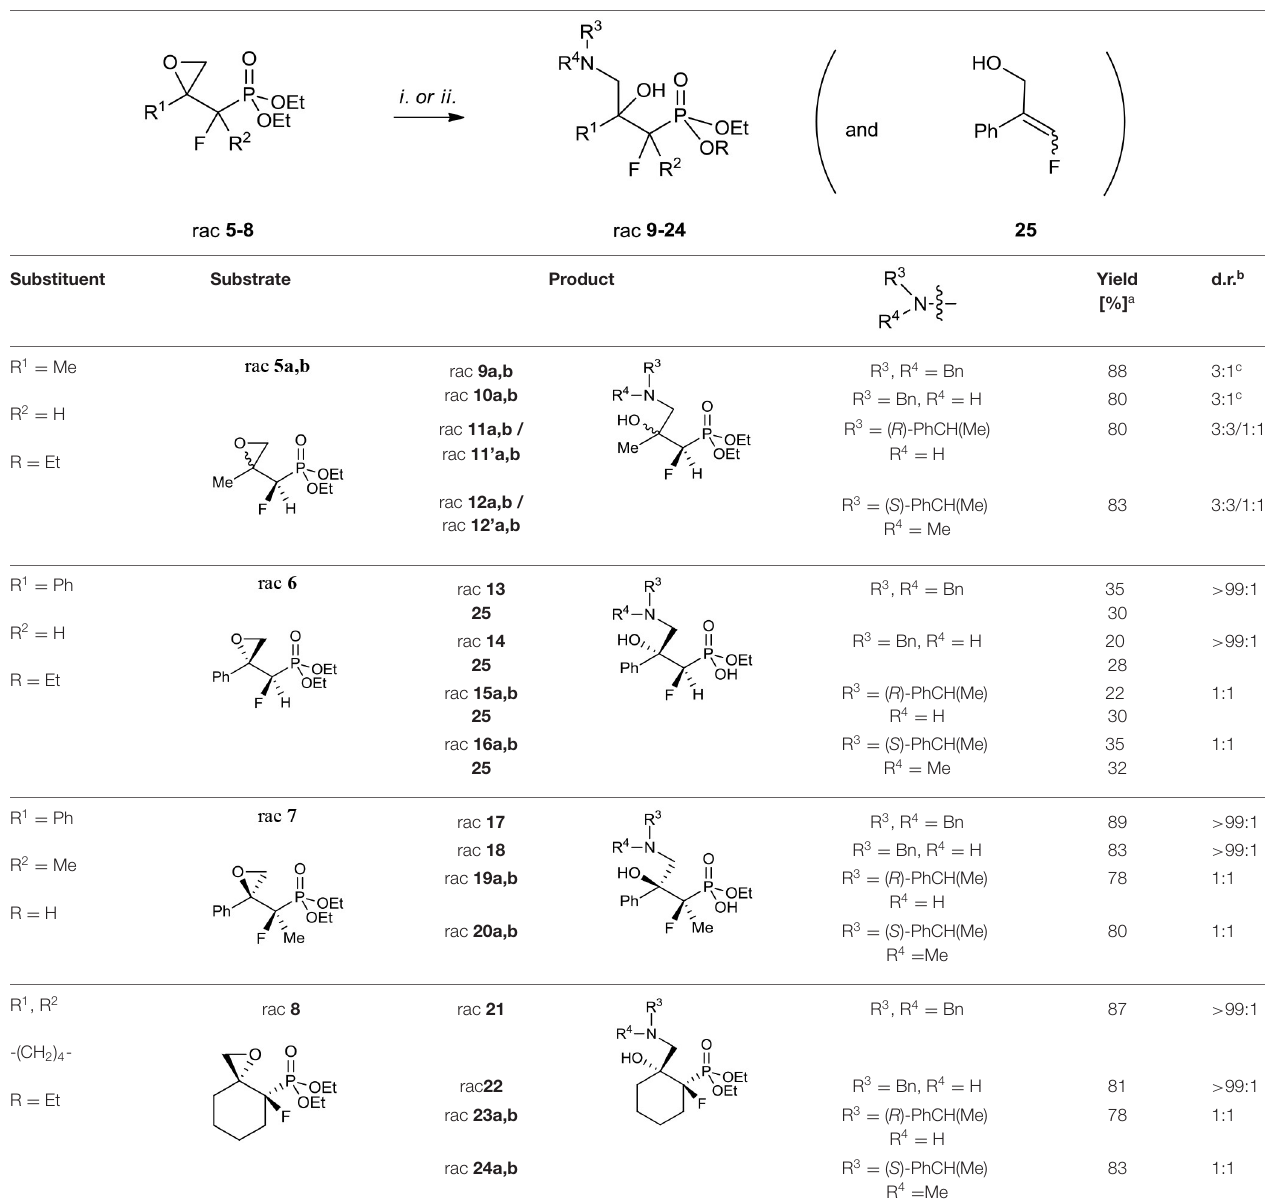
TABLE 4 | Synthesis of γ -amino- β -hydroxy alkylphosphonates 9–24 and 25 .